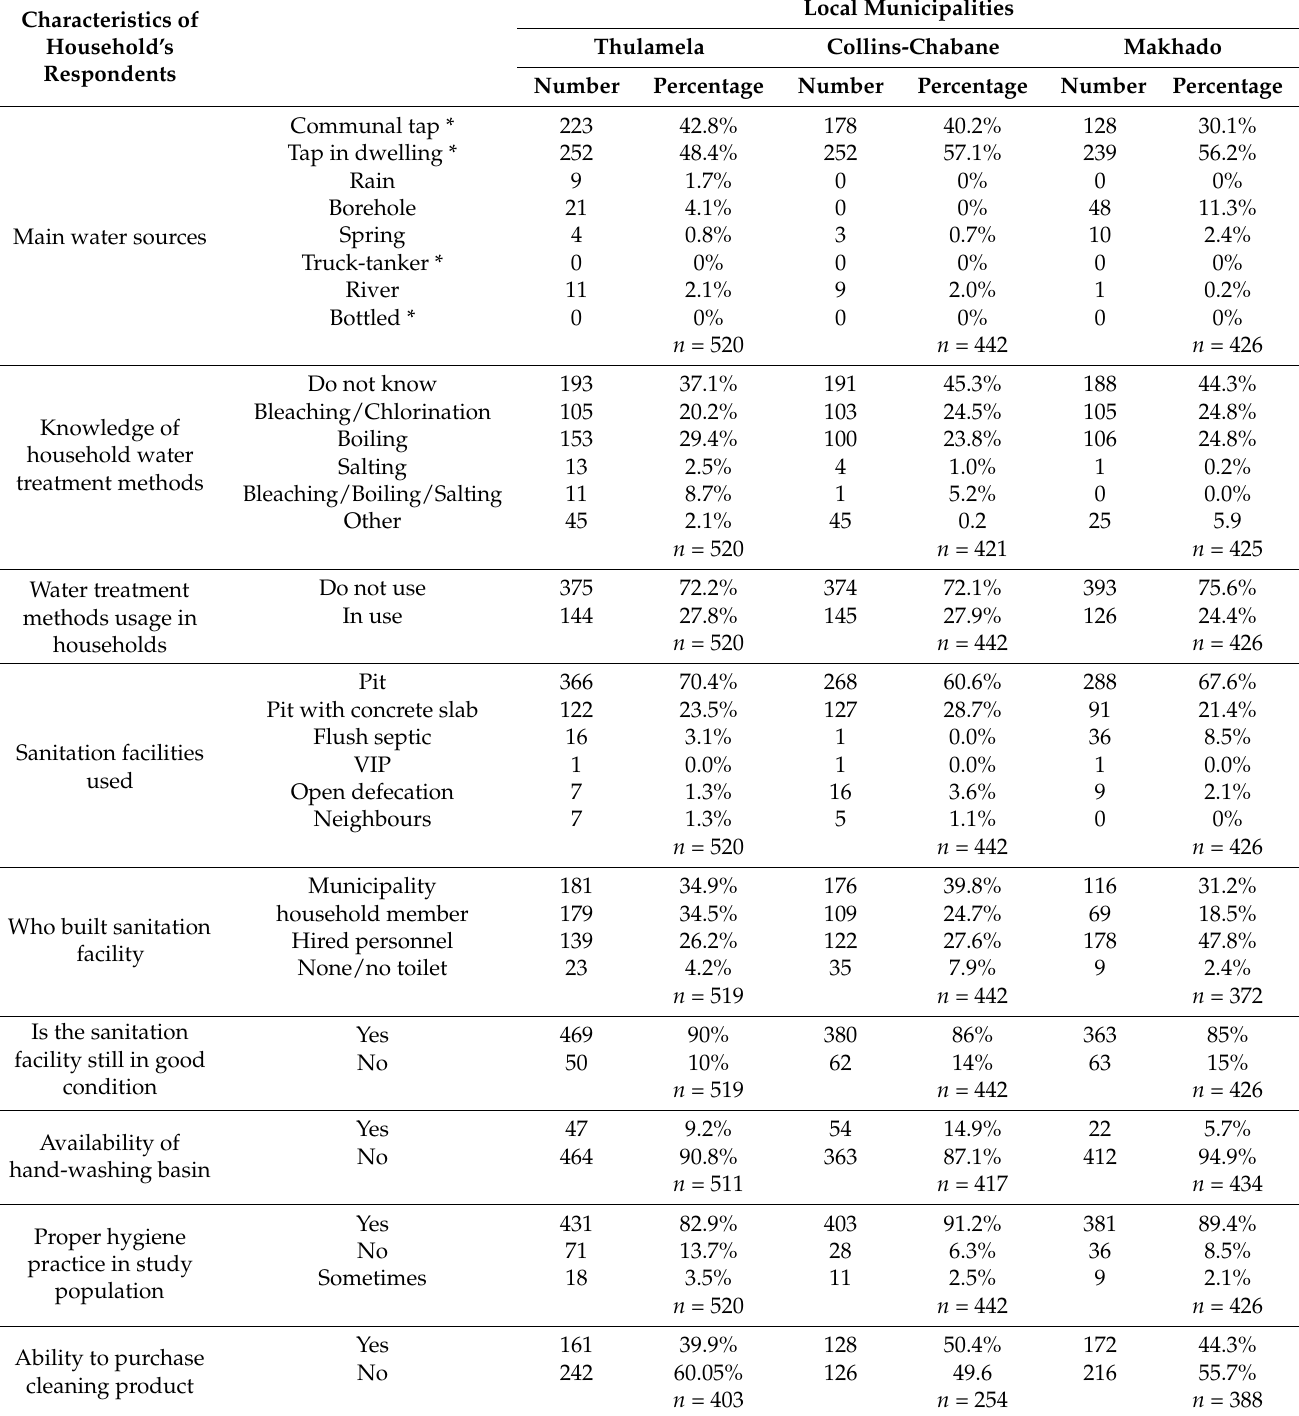
Table 2. Characteristics of WASH distribution across the three LMs in